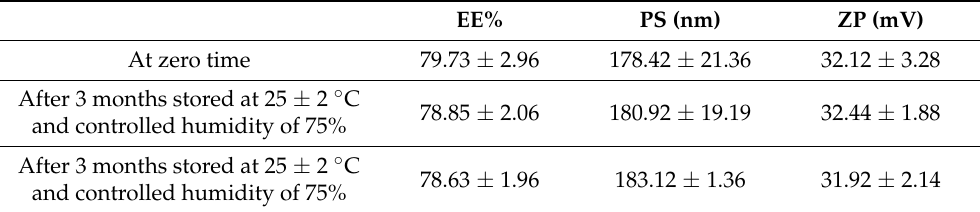
Table 5. Stability study of the optimized EH-loaded emulsomes formulation (F10). EE%